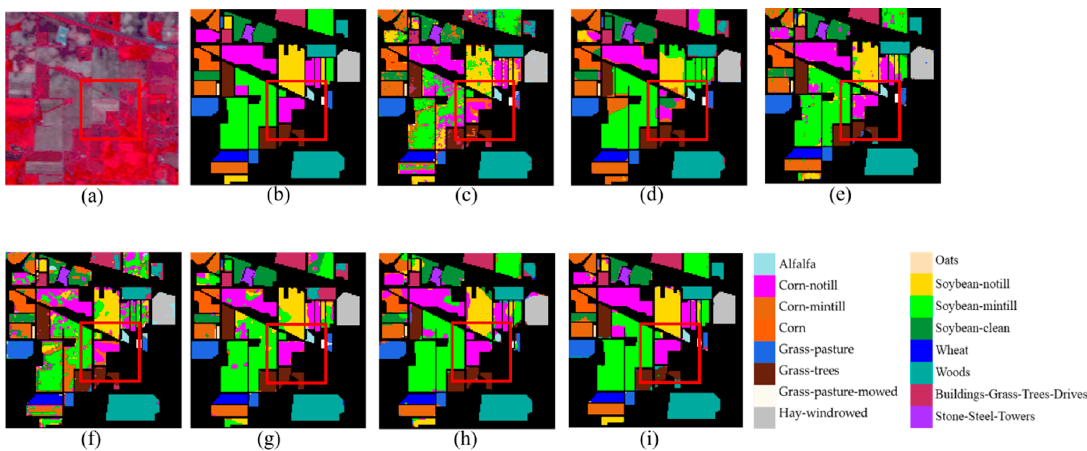
Figure 6. Classification maps of Indian Pines dataset. ( a ) False color image. ( b ) Reference image. ( c ) CCF. ( d ) SVM-3DG. ( e ) 2D-CNN-transfer. ( f ) 3D-CNN. ( g ) SSRN. ( h ) MSDN. ( i ) MSDN-SA.